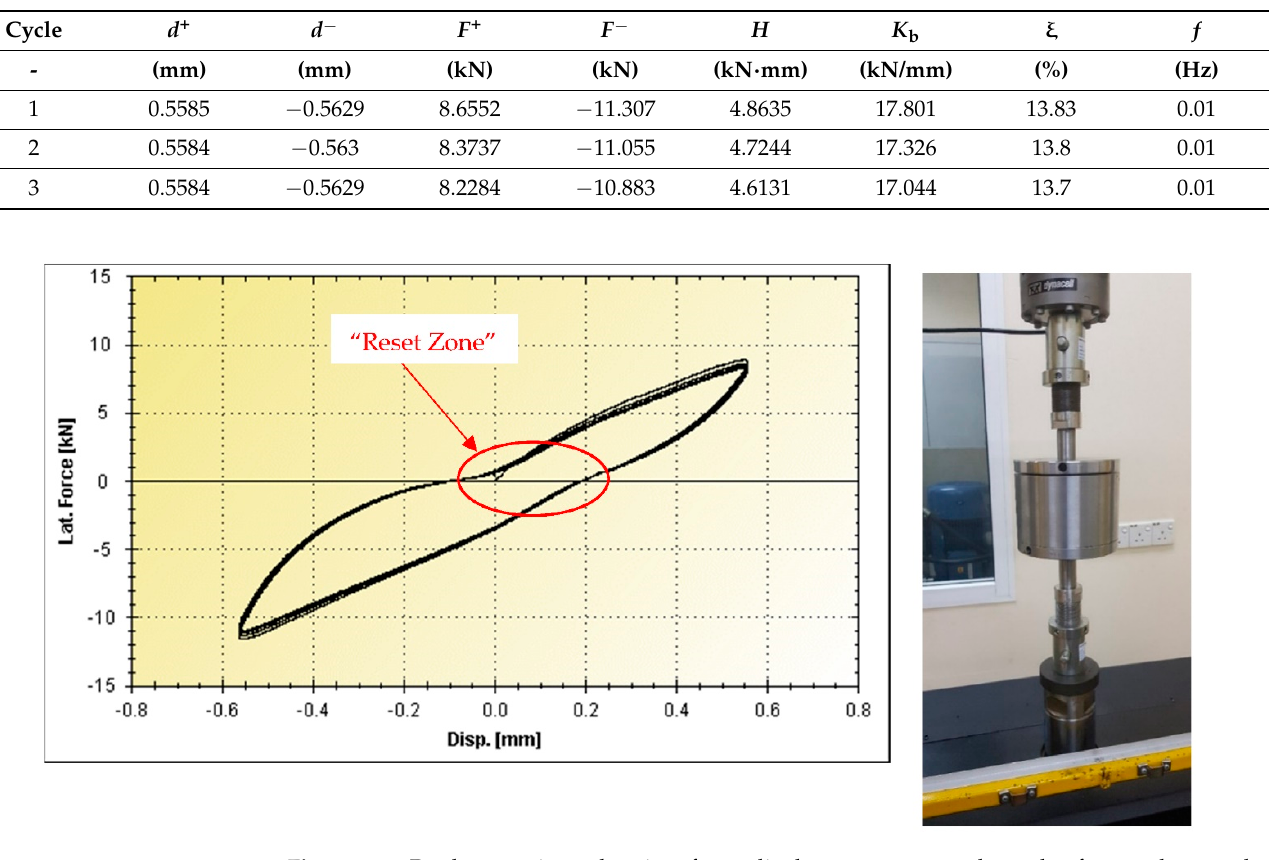
Figure 7. Product testing, showing force–displacement test and results for product under cyclical